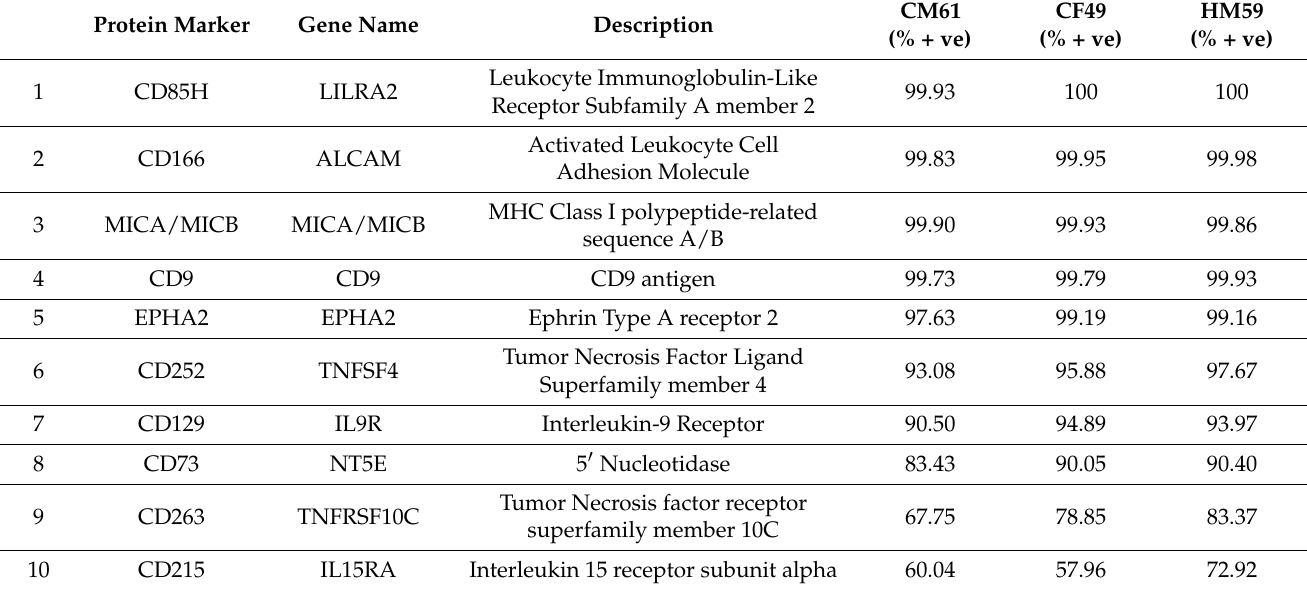
Table 1. Top 10 surface markers expressed on all CTC lines with more than 30% of one of the cell lines expressing the marker. The percentage positive fractions of each CTC line are